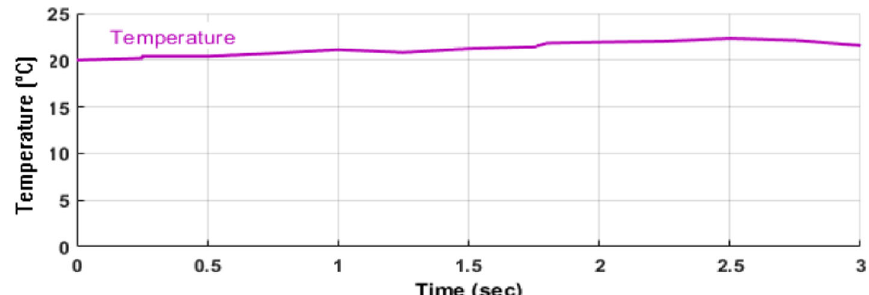
Fig. 16 Temperature waveform